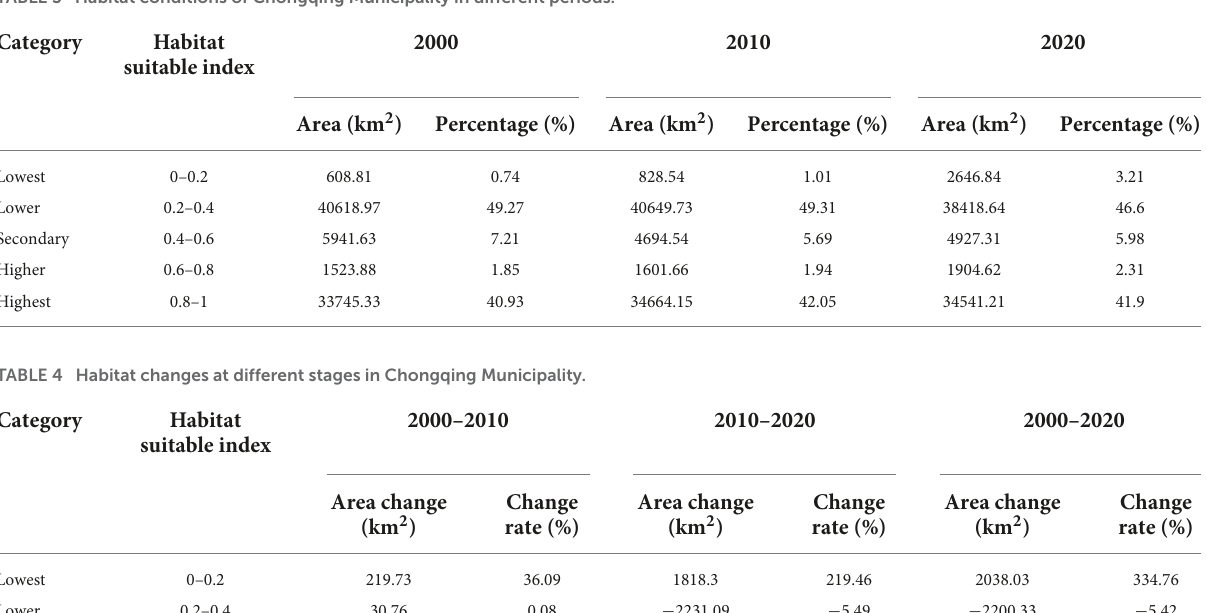
TABLE 3 Habitat conditions of Chongqing Municipality in different periods.